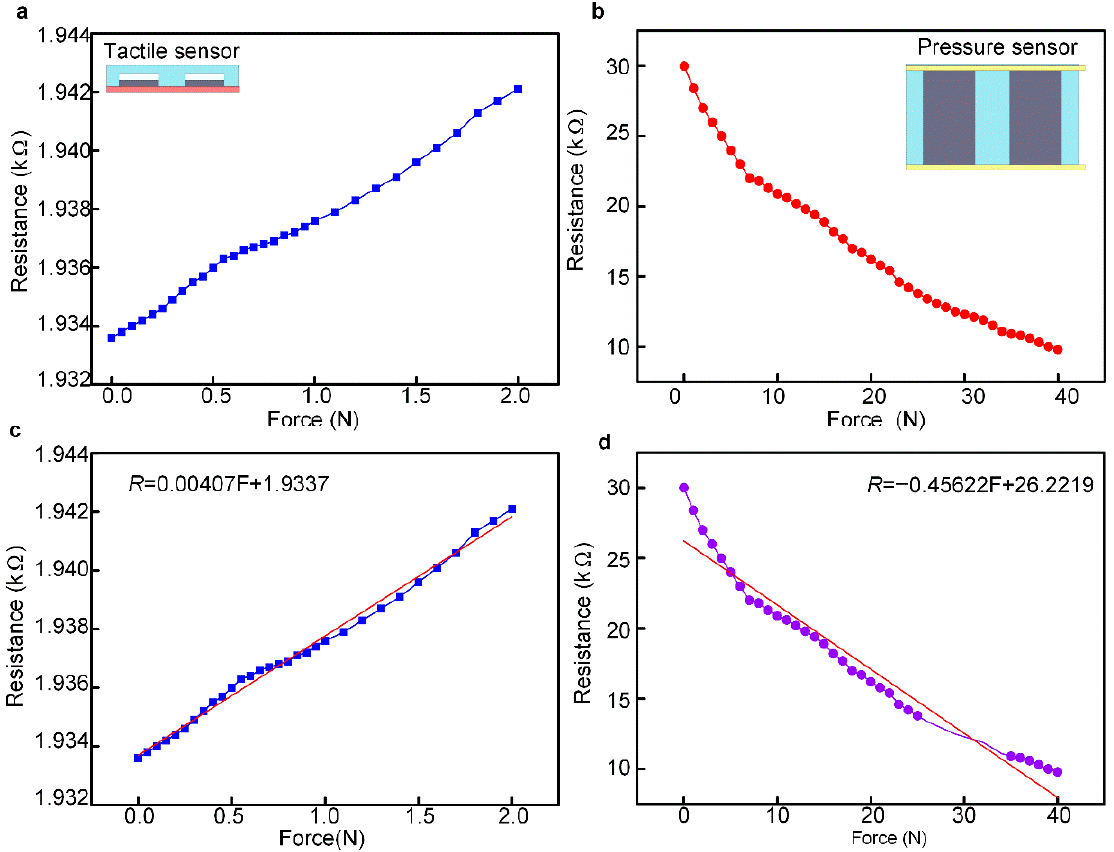
Figure 7. The output properties of the flexible bionic tactile-pressure sensor. ( a ) The relationship between the force and output resistance of the tactile sensor. ( b ) The relationship between the force and output resistance of the pressure sensor. ( c ) The fitting result of the force and output resistance of the tactile sensor by using the least-squares method. ( d ) The fitting result of the force and output resistance of the pressure sensor by using the least-squares method.